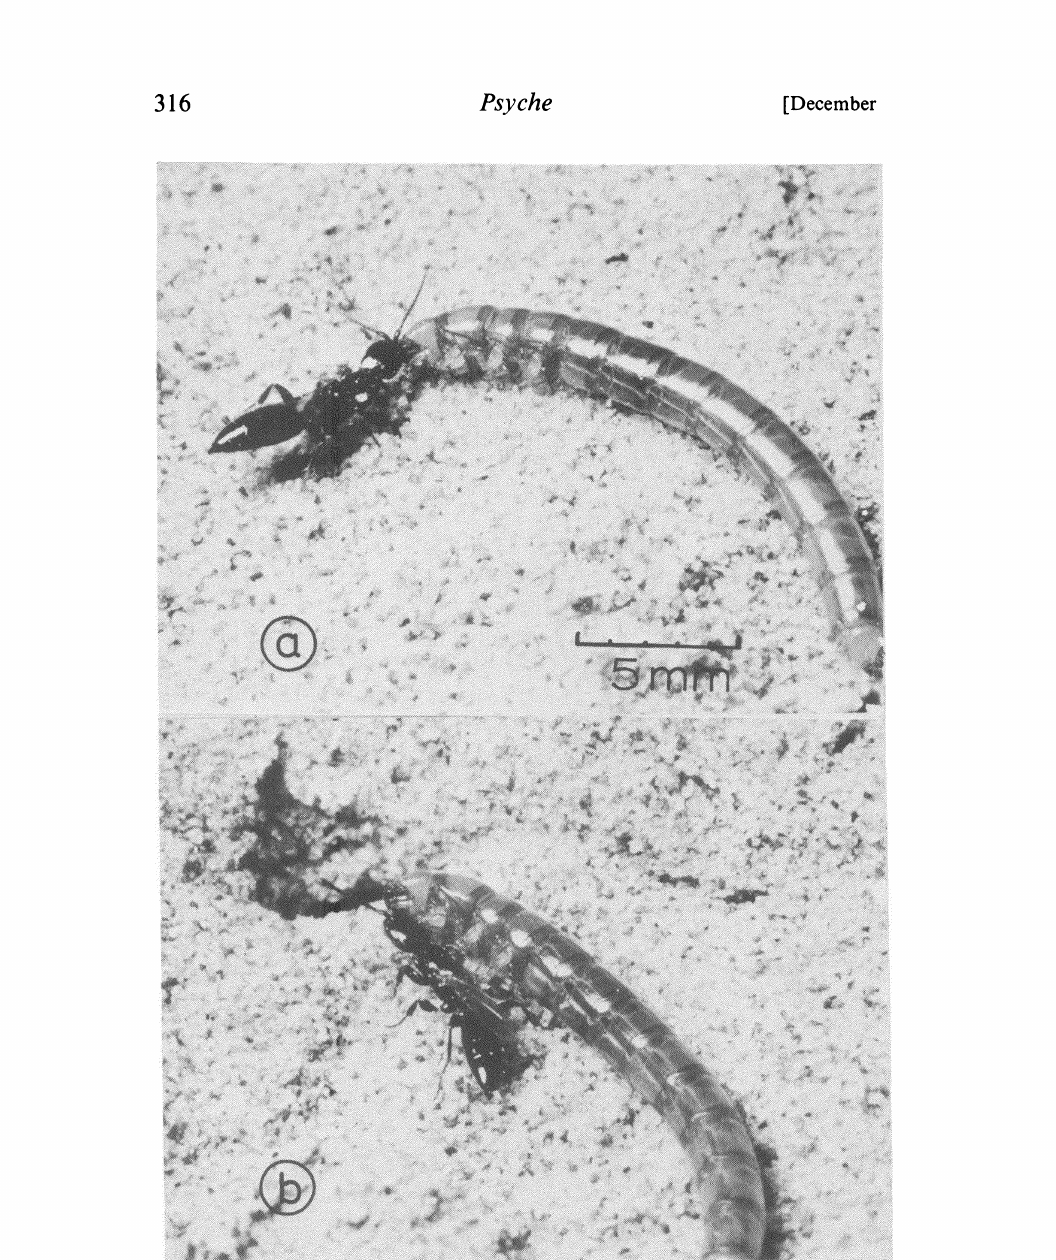
Fig. 2. Epyrus eriogoni dragging its Blastinus sp. prey: a) backwards along the soil surface, and b) forward along the soil surface and toward the nest